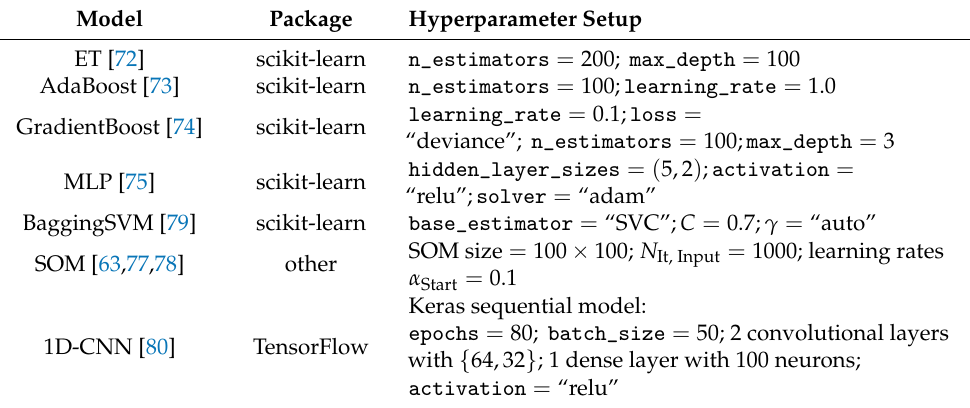
Table A2. Hyperparameter setup for the classification approaches. The approaches were implemented